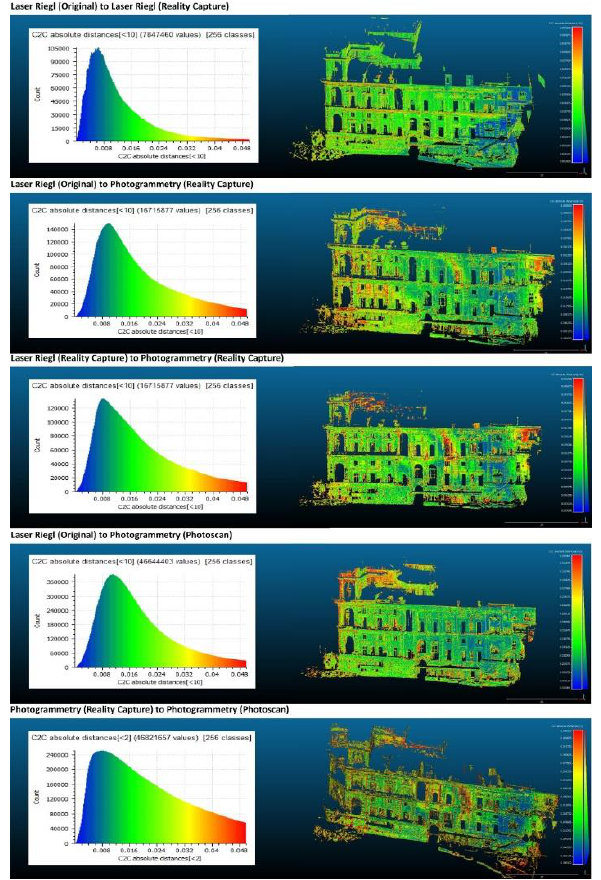
Figure 5. Deviation maps of the different outputs, compared in pairs